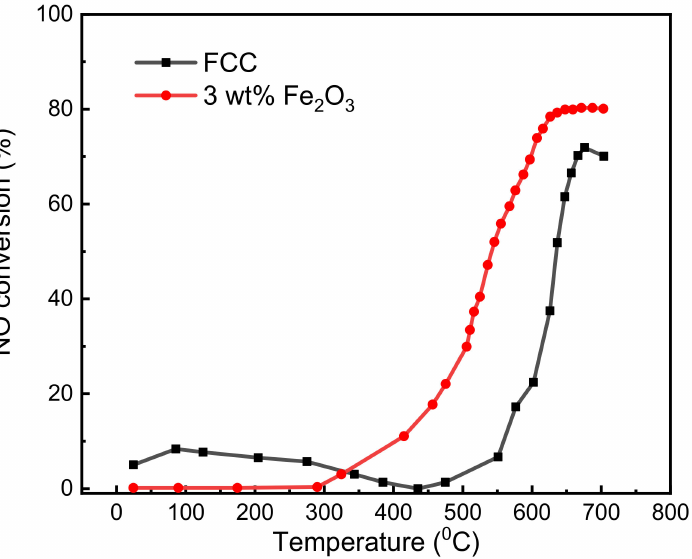
Figure 34. Comparison of Fe-based and FCC catalyst NO conversion performance. Data obtained from Leger et al.